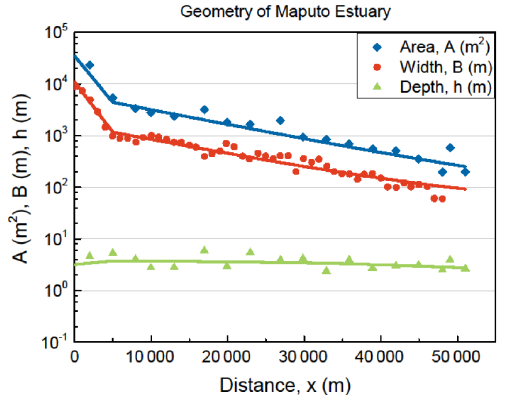
Figure 2. Geometry of the Maputo Estuary, showing the cross- sectional area A (blue diamonds), the width B (red dots), and the depth h (green triangles) on a logarithmic scale as a function of the distance from the mouth. The inflection point at x 1 = 5000m sepa- rates the lower segment with a convergence length of a 0 = 2300m from the upper segment with a 1 = 16000m.